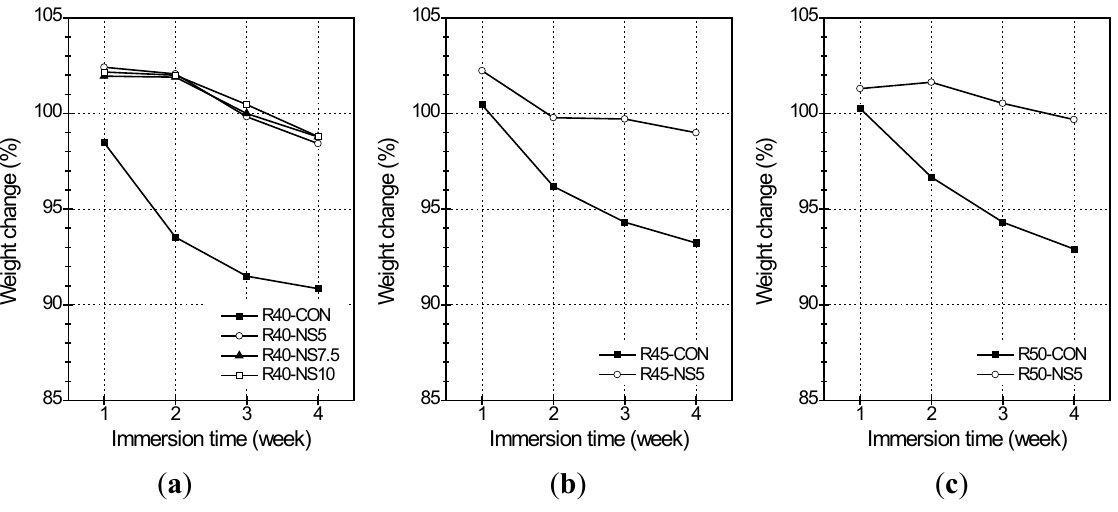
Figure 7. Weight change of cylinders with ( a ) W/C of 40%; ( b ) W/C of 45%; and ( c ) W/C of 50% in relation to W/C and immersion time.